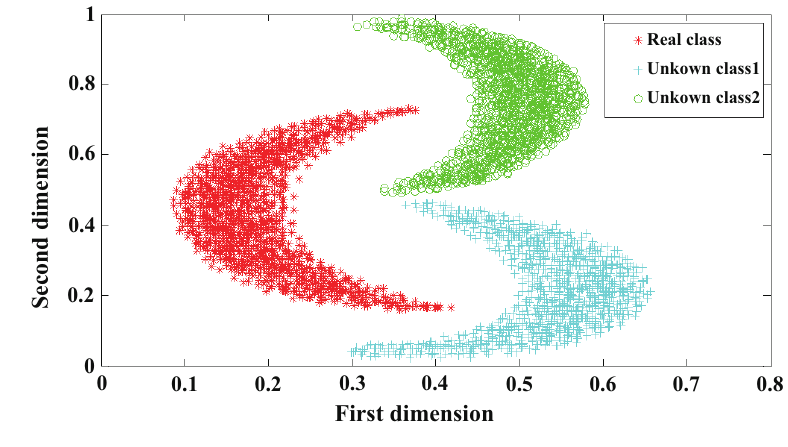
Figure 4. Feature